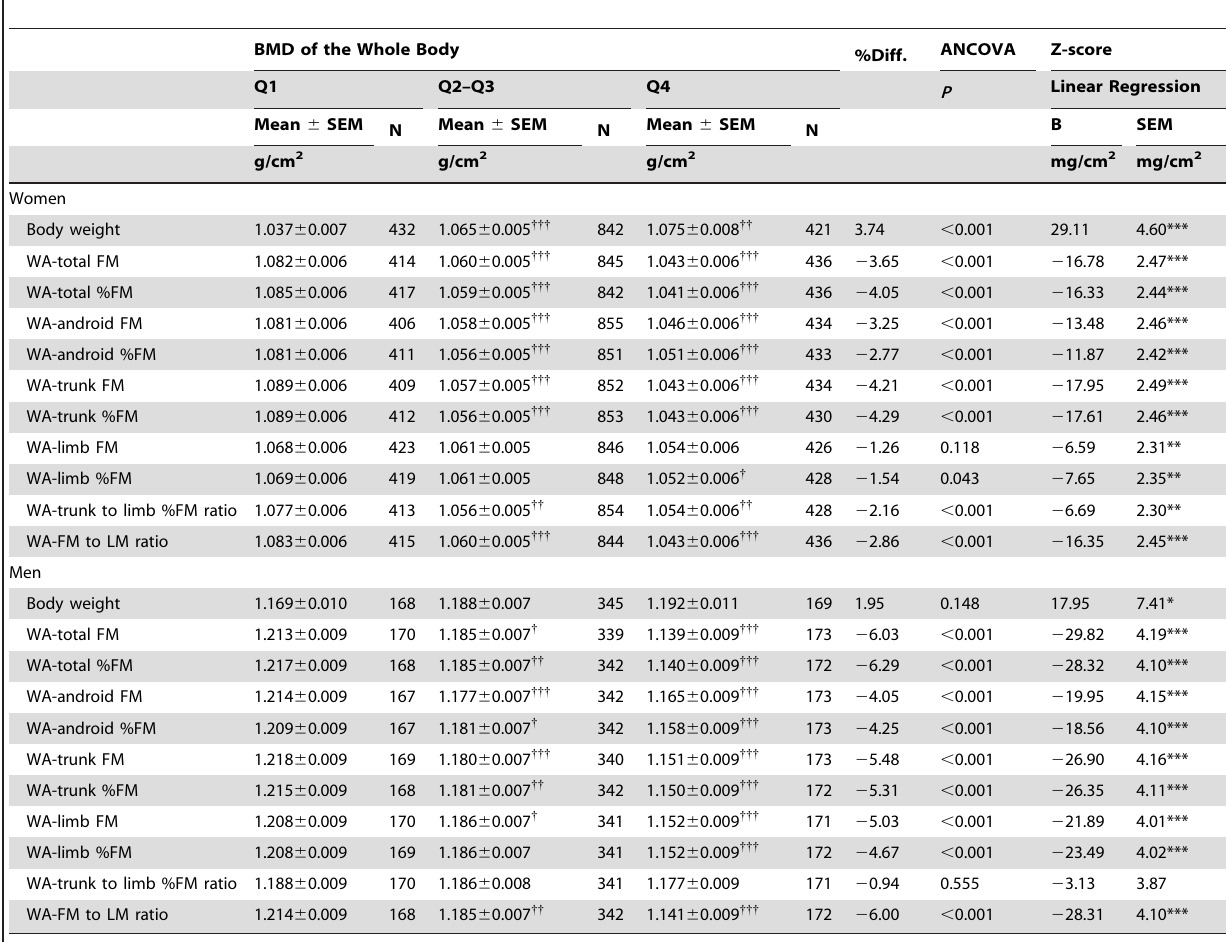
Table 4. Covariate-adjusted mean (SEM) bone mineral density of the whole body by quartiles of each WA-index of FM.